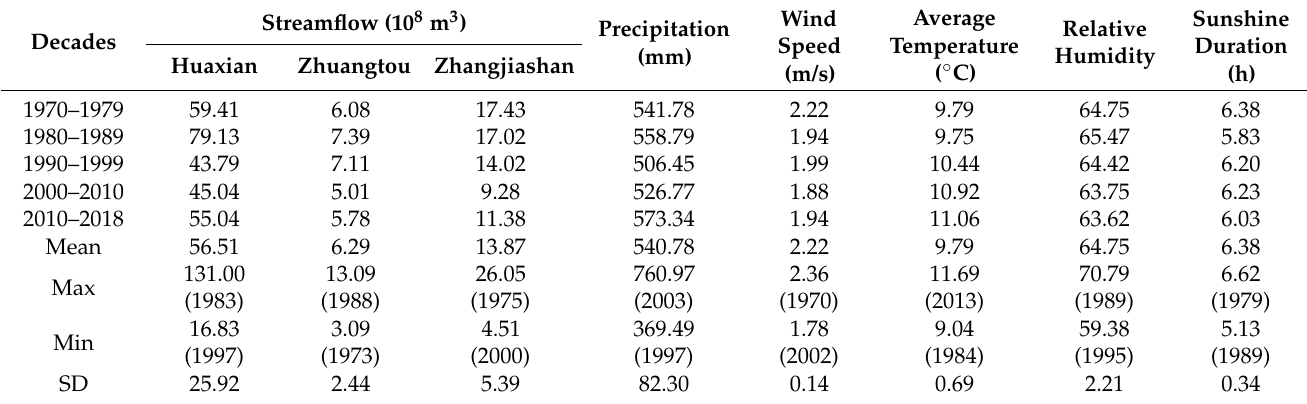
Table 2. Characteristics of meteorological and hydrological data in Wei River Basin.